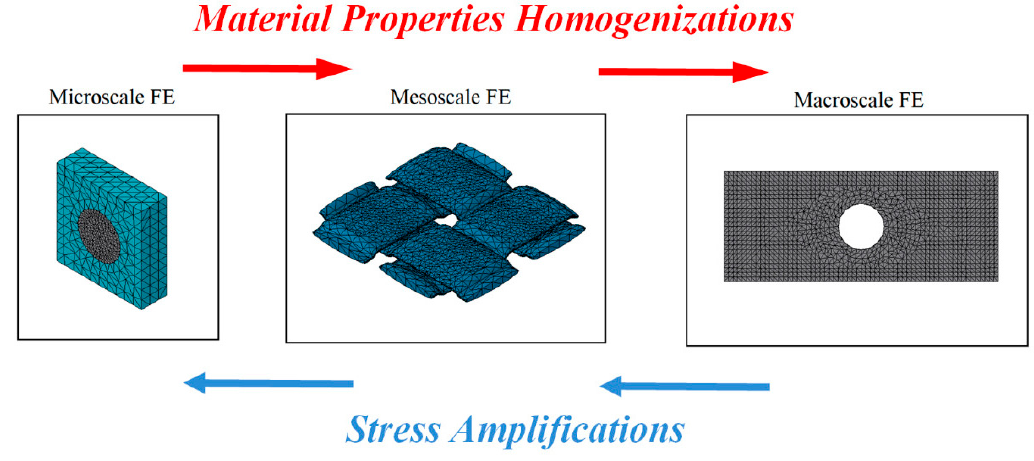
Figure 9. Multiscale modelling strategy for woven composite laminates.